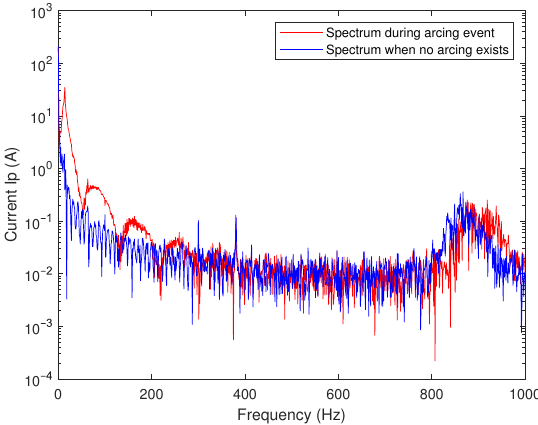
Figure 7. Frequency spectrum of I p during and after arc